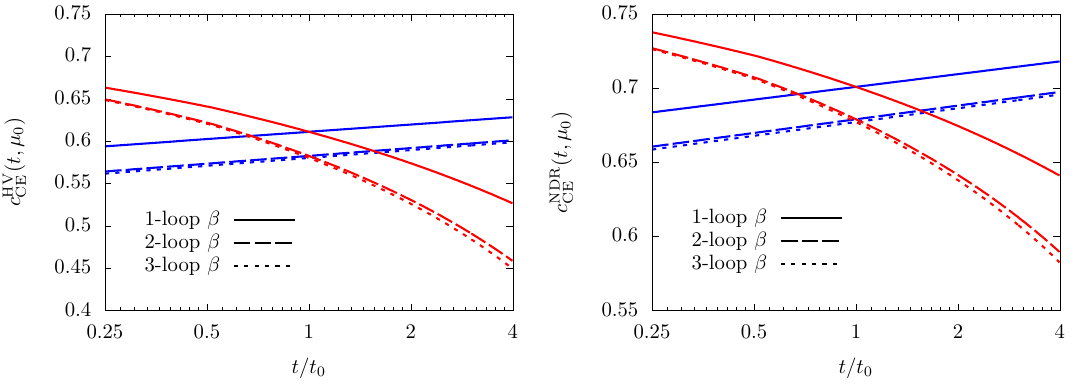
Figure 4 . Scale dependence of the matching coefficient c CE . The left (right) plot shows the result in the HV (NDR) scheme. Detailed explanations are given in the main